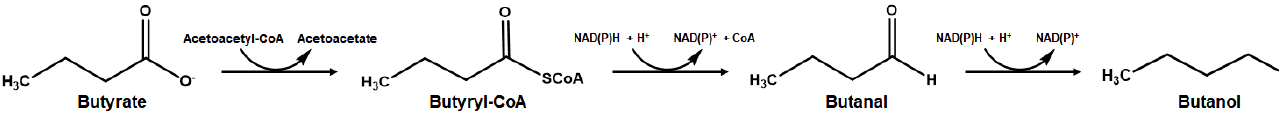
Figure 1. Butanol synthesis in F. nucleatum .